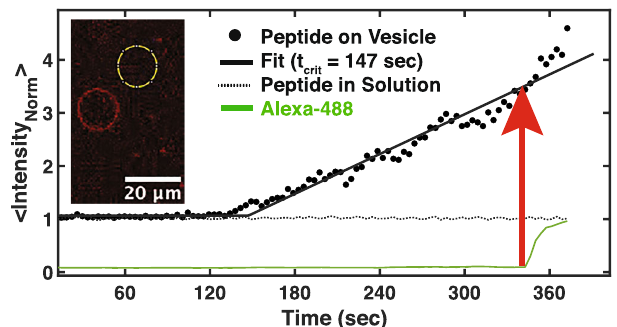
Fig. 9 | Kinetics of poration and FP accumulation on a POPC GUV. FP fl uores- cence signals were normalized by the FP mean intensity in solution (black data points).ThetimeFPbeginstoaccumulateonthevesicle,t crit ,wasdeterminedusing piecewise linear fi tting (solid black lines). The time, t pore , poration begins (red arrow) was determined using piecewise linear and exponential fi tting of the Alexa 488 in fl ux (solid green line). In this example, the characteristic time between FP accumulationandporationis197secwithameanFPintensityatporation3.5times thesolutionintensity.FPmeanintensityinsolutionwasconstantovertime(dotted black line). Inset) Confocal image of an FP labeled vesicle (red) and control ring (yellow), positioned in the solution, used to evaluate circumferential intensity of both the vesicle and solution as a function of time. Representative example from n=9 experiments. Source data are provided as a Source Data fi